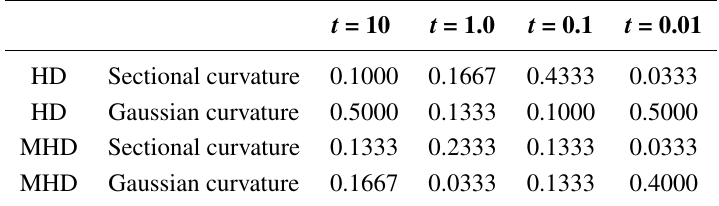
Table 1. Rand index vs. t for the York Model Houses